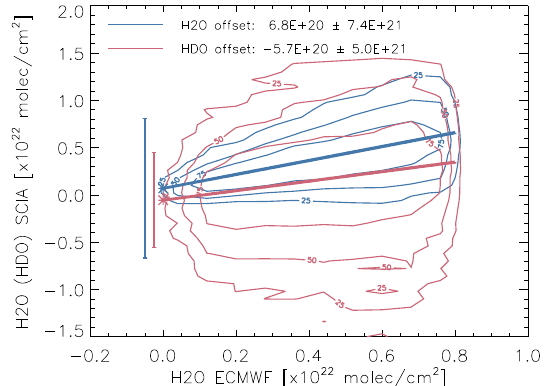
Figure 4. Cumulative density distributions (showing the 25, 50 and 75 percentiles) of H 2 O (blue) and HDO (magenta, divided by the VSMOW abundance of 3.1153 × 10 − 4 ) total columns measured by SCIAMACHY vs. the H 2 O columns from ECMWF for a box over Greenland. The thick lines show linear regressions, with their lower- left starting points, indicated by the asterisks, being the constant off- sets. The error bars are shifted to the left for readability and denote the uncertainty in the offset.